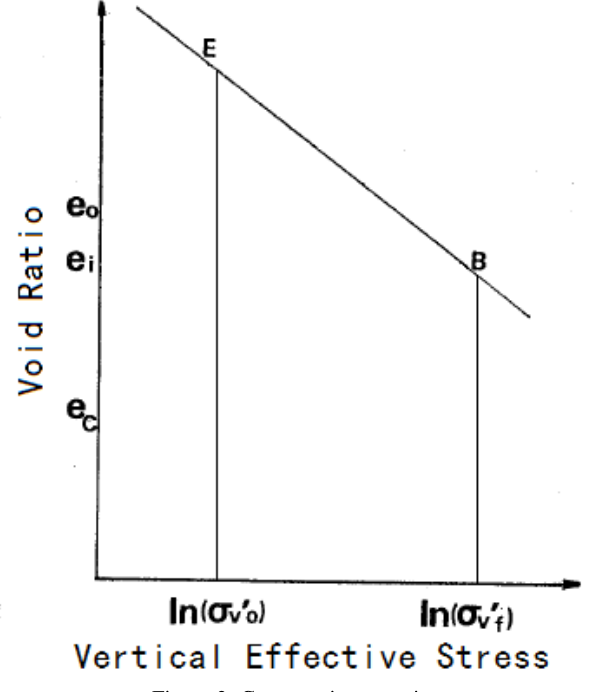
Figure 2. Compression